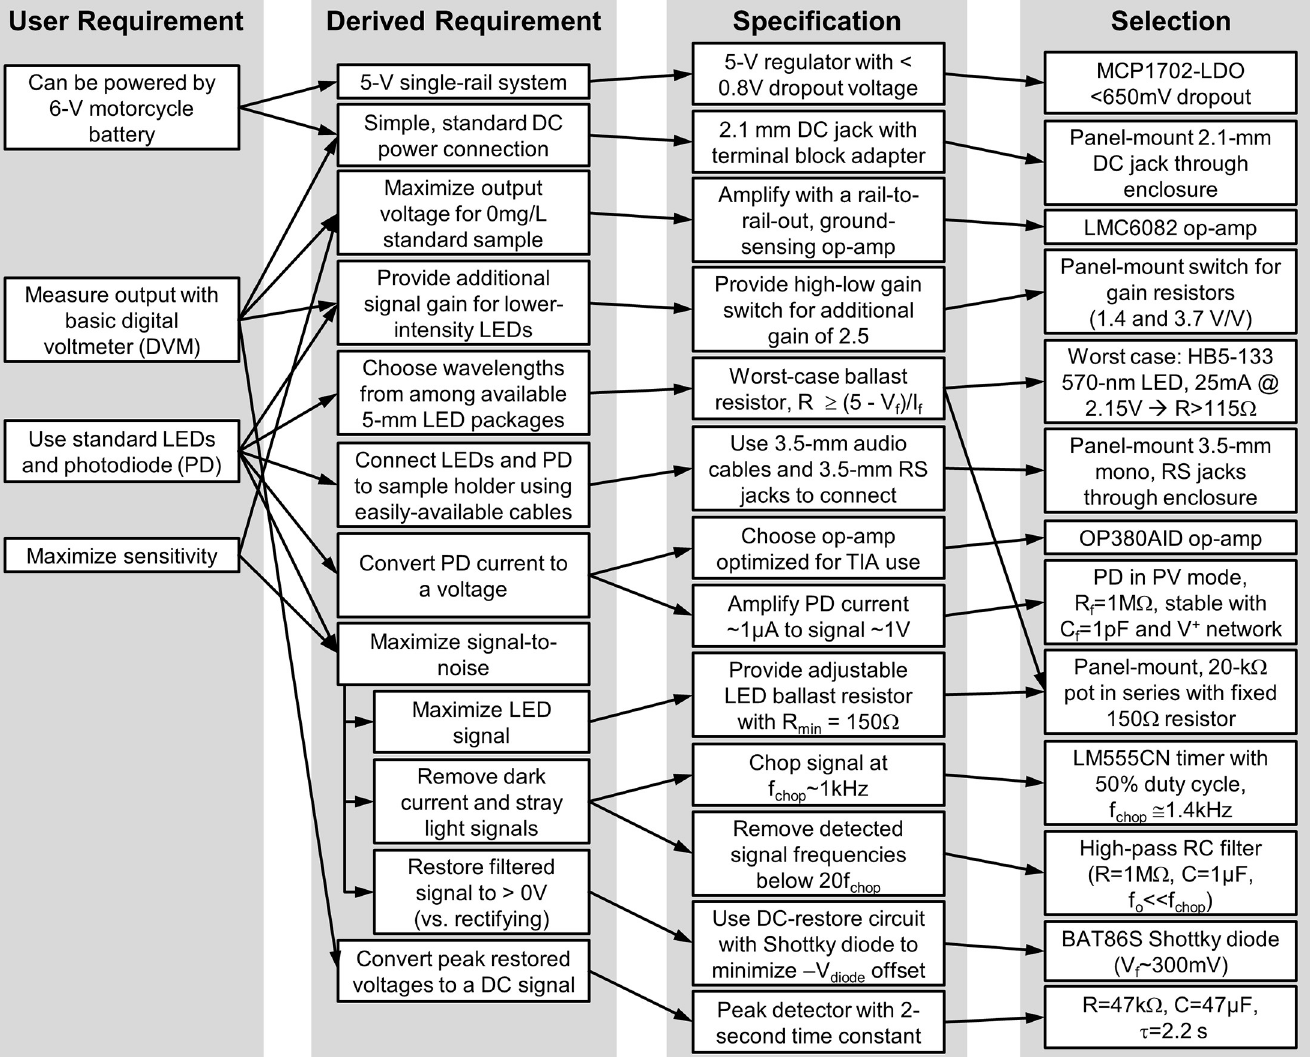
PLOS ONE | https://doi.org/10.1371/journal.pone.0226761 January 29,